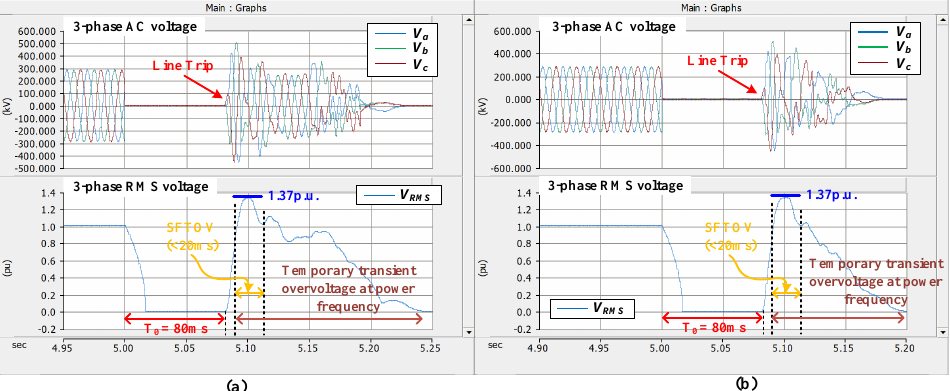
Figure 10. PSCAD/EMTDC simulation results according to SPS signal transfer time delay. ( a ) 70 ms and ( b ) 20 ms.